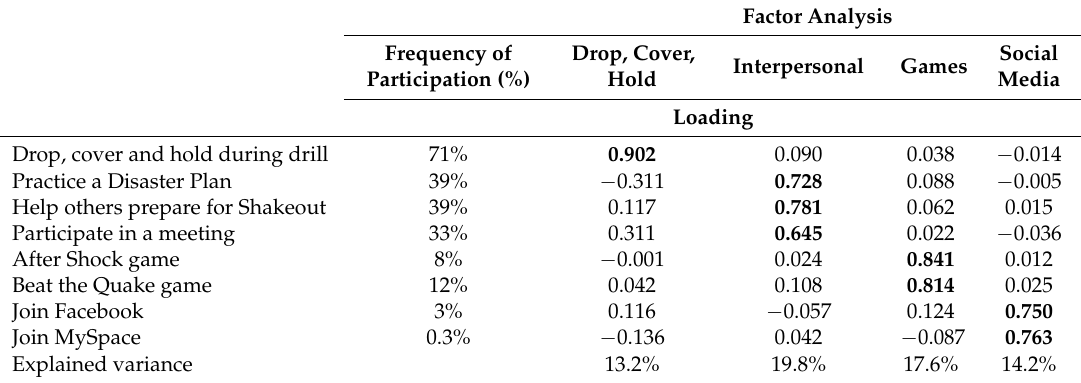
Table 2. Factors derived from participation in ShakeOut activities ( N =